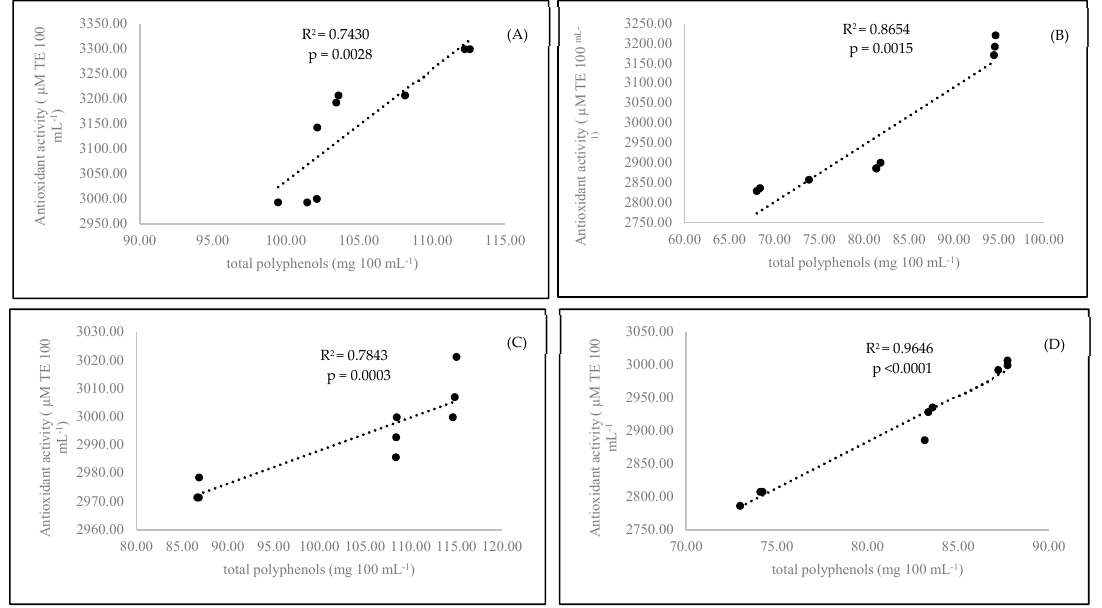
Figure 2. Linear regression (Pearson’s coefficient R 2 ) between antioxidant activity and total polyphenols in organic 3-minutes-brewing coffee ( A ), conventional 3-minutes-brewing coffee ( B ), conventional 6-minutes-brewing coffee ( C ), and conventional 6-minutes-brewing coffee ( D ). PCA showed a high and significant overall variation of 71.56% that was explained by PC1 and PC2 (Figure 3). The degree of dependence between the organic co ff ee preparation method and the factors marked as antioxidant activity (AA) and ca ff eine (CaF), chlorogenic acid (ChlA), epigalocatechin (EGC), kaempferol (K), total polyphenol (TP), and total phenolic acid (TPA) contents was particularly important (Figure